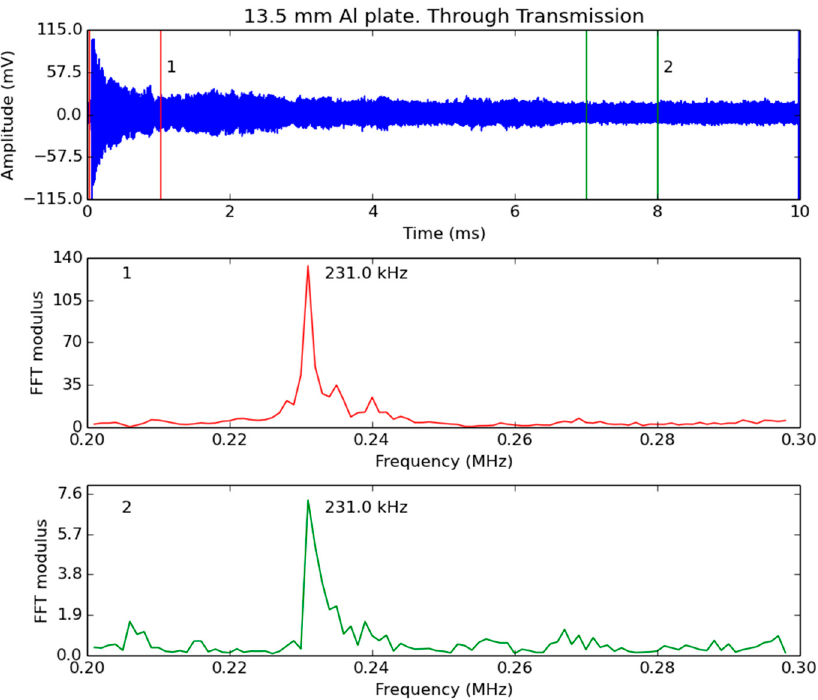
Figure 5. Through-transmission in the 13.5 mm-thick aluminum plate. Top: signal in the time domain. Center: FFT modulus of the signal within window (1). Bottom: FFT modulus of the signal within window (2).